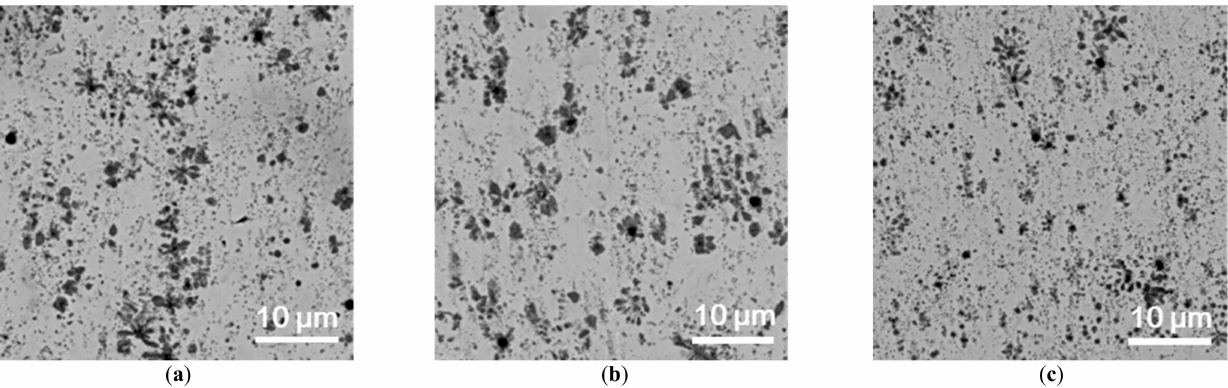
Figure 8. Microstructure of ( a ) EEMMC2.0-T, ( b ) EEMMC2.0-C, and ( c )